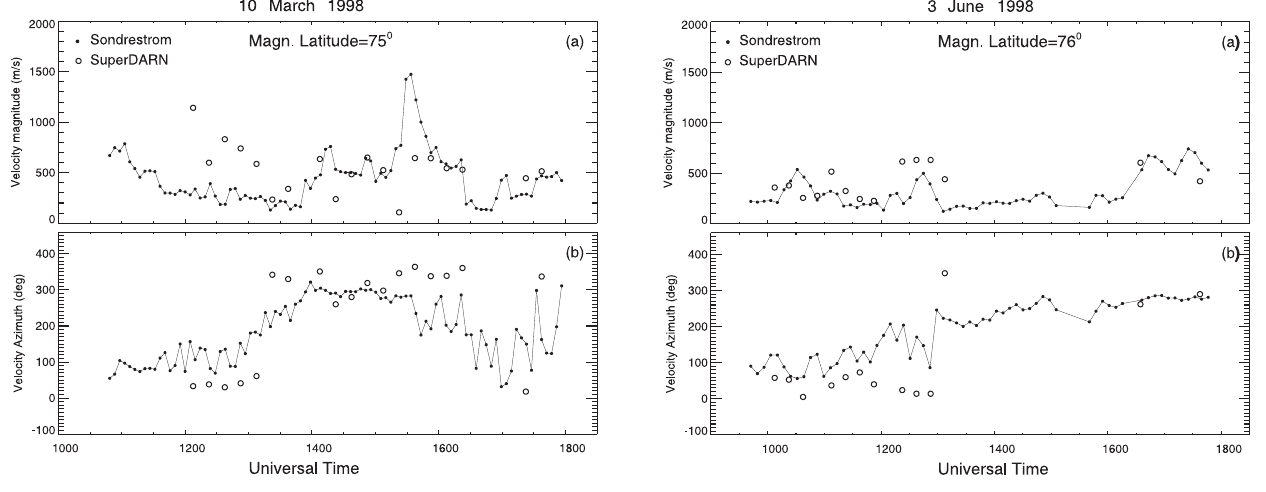
Fig. 2. Average plasma drifts (panel (a) for the magnitude, panel (b) for the azimuth) at magnetic latitudes of 74.75 ◦ –75.25 ◦ ac- cording to the Sondrestrom ISR (solid small circles and line) and Stokkseyri-Goose Bay HF radars (15 min averages; open circles) on 10 March 1998. Azimuth was counted clockwise from the direc- tion of geographic north.